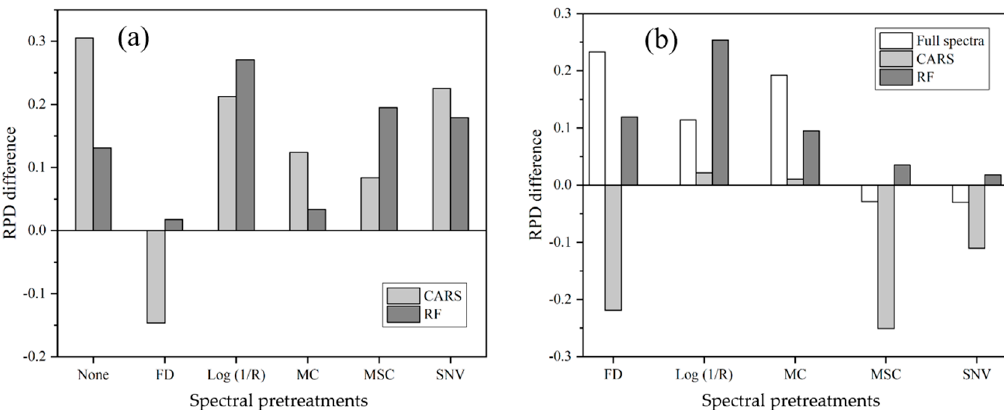
Figure 9. ( a ) Ratio of prediction deviation (RPD) difference between competitive adaptive reweighted sampling (CARS)/random frog (RF) and full spectrum SOC models after the same spectral pretreatments (spectral pretreatments include non-pretreatment (None), first derivative (FD), Log (1/R), mean centering (MC), multiplicative scatter correction (MSC), and standard normal variate (SNV)); ( b ) RPD difference between non-pretreated and pretreated SOC models after the same variable selection algorithms (variable selection algorithms include full spectrum, CARS, and RF).